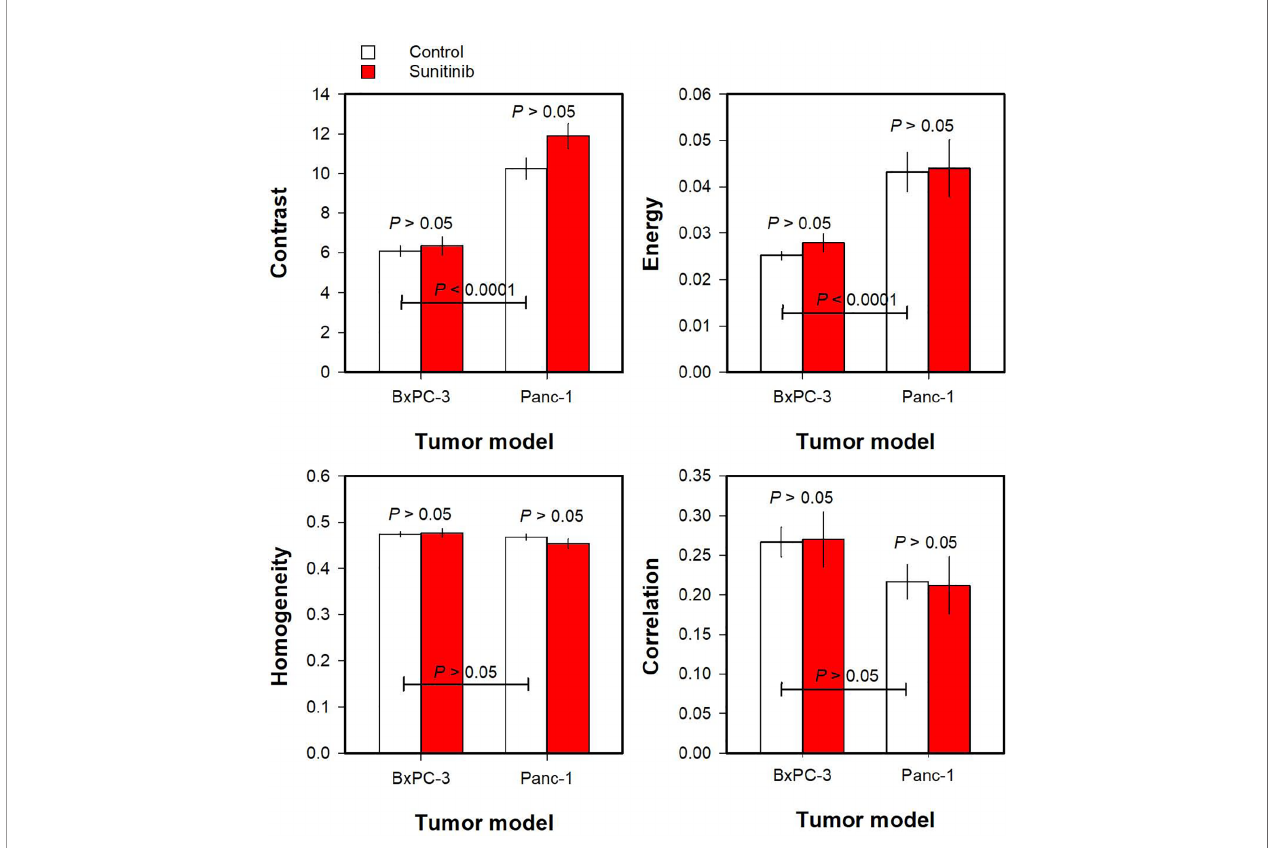
FIGURE 4 | The Haralick features Contrast, Energy, Homogeneity, and Correlation derived from K trans maps of untreated and sunitinib-treated BxPC-3 tumors and untreated and sunitinib-treated Panc-1 tumors. Columns and bars, mean ± SEM of 10-20